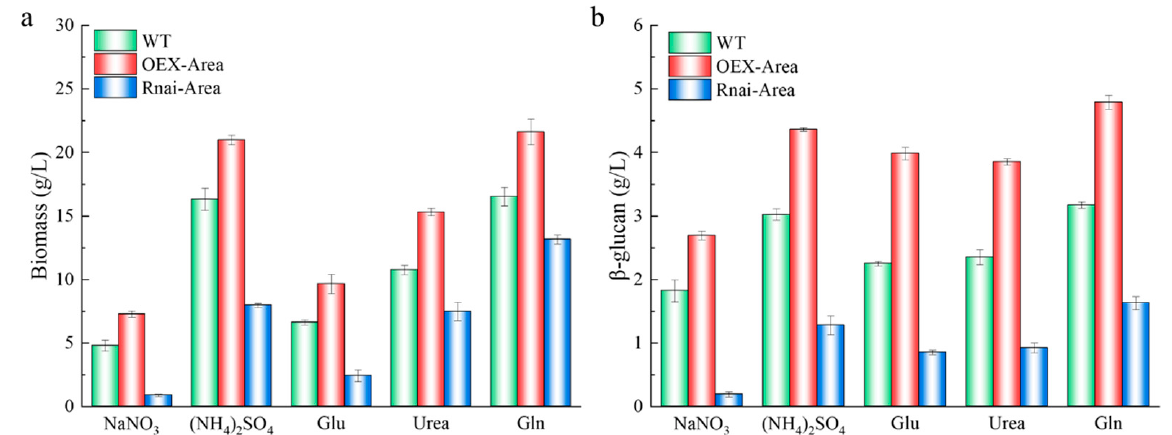
Figure 6. Effects of various nitrogen sources of Area mutant strains. ( a ) biomass. ( b ) β -glucan yield. 3.7. Expression Quantity of Genes Associated with β -Glucan Synthesis